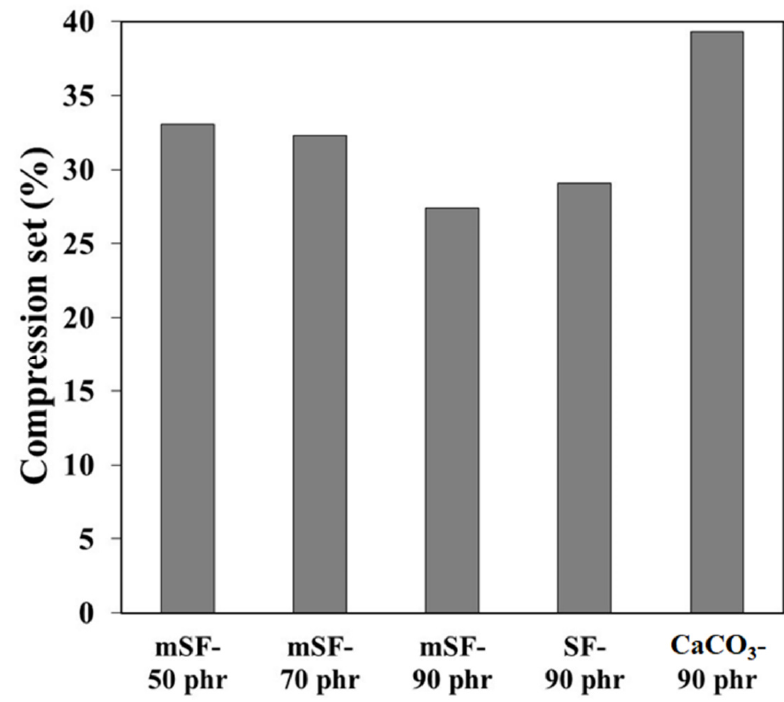
Figure 4. Compression set of EPDM